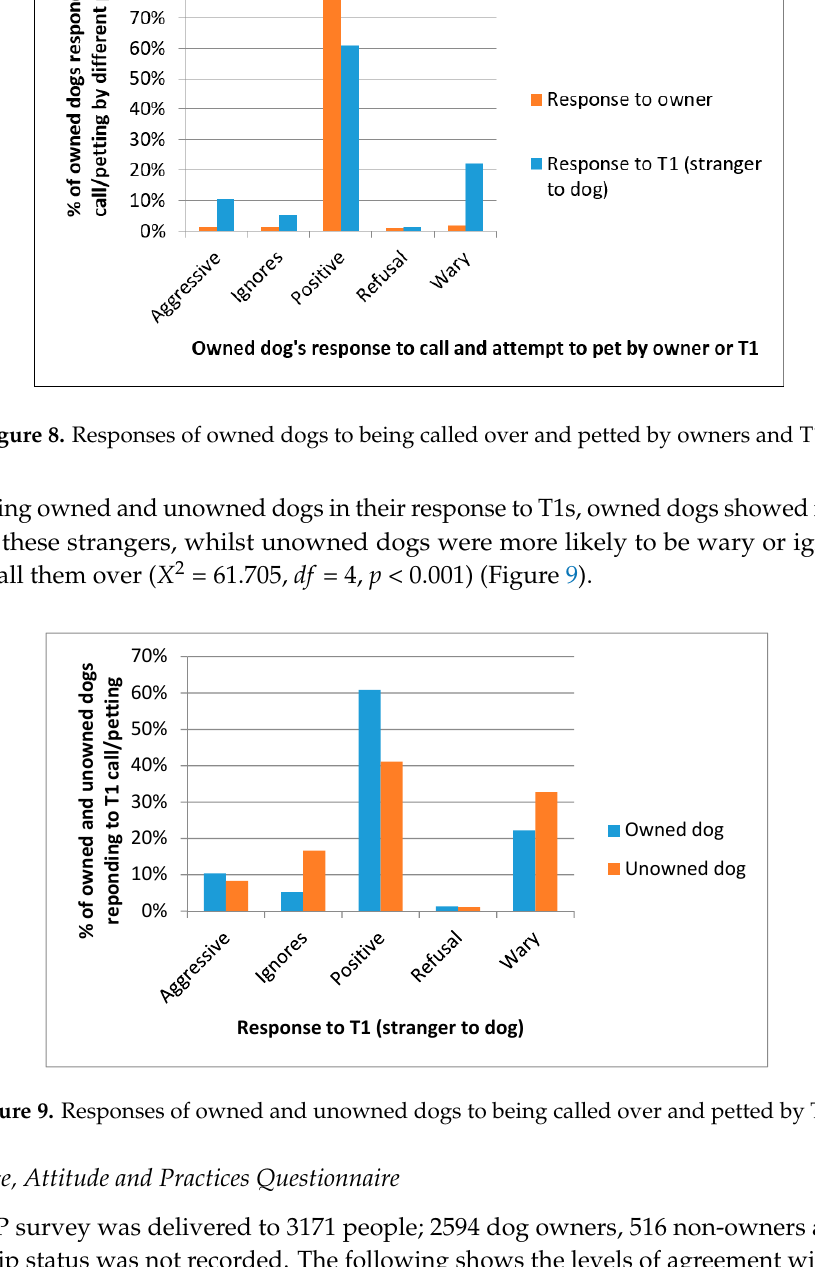
Figure 9. Responses of owned and unowned dogs to being called over and petted by T1s.